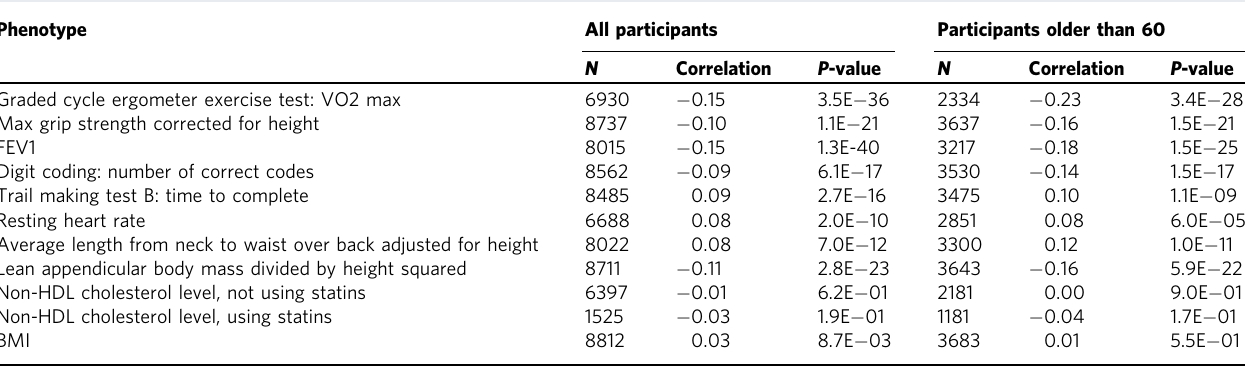
Table 2 Correlation of 5-year mortality risk predicted by the protein model and corrected for age and sex with frailty related phenotypes in the dHS